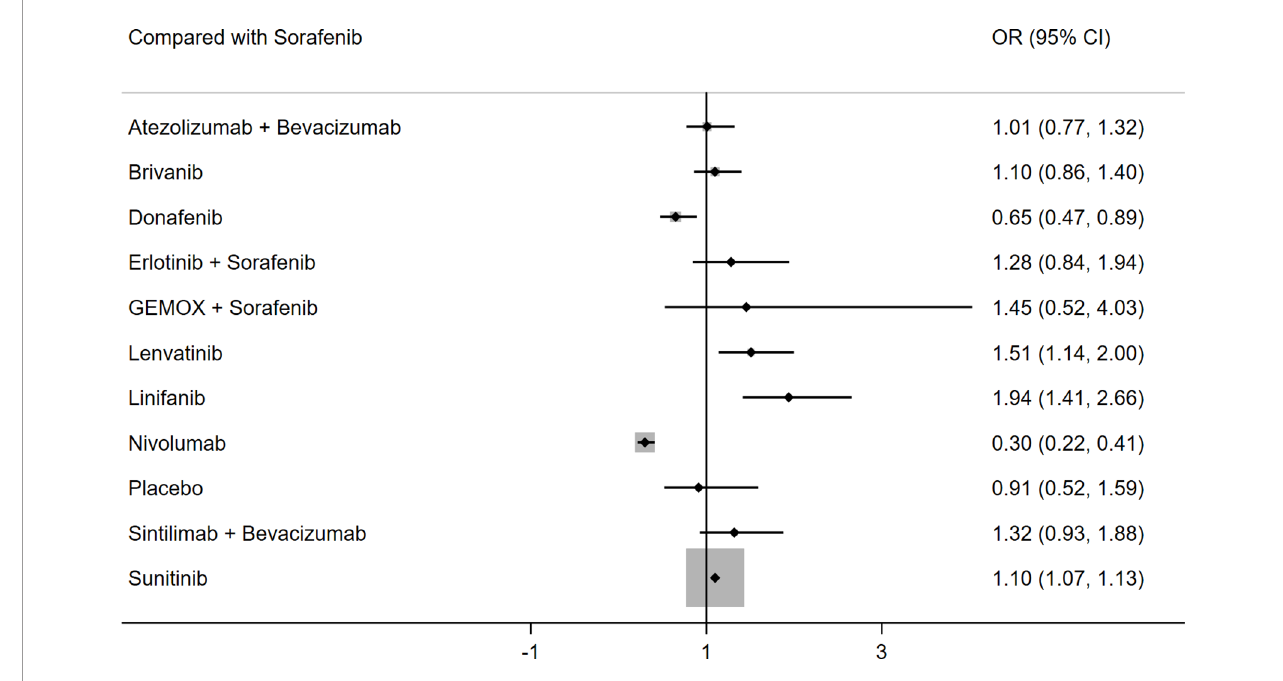
FIGURE 5 | Forest plot for OR of grade 3-5